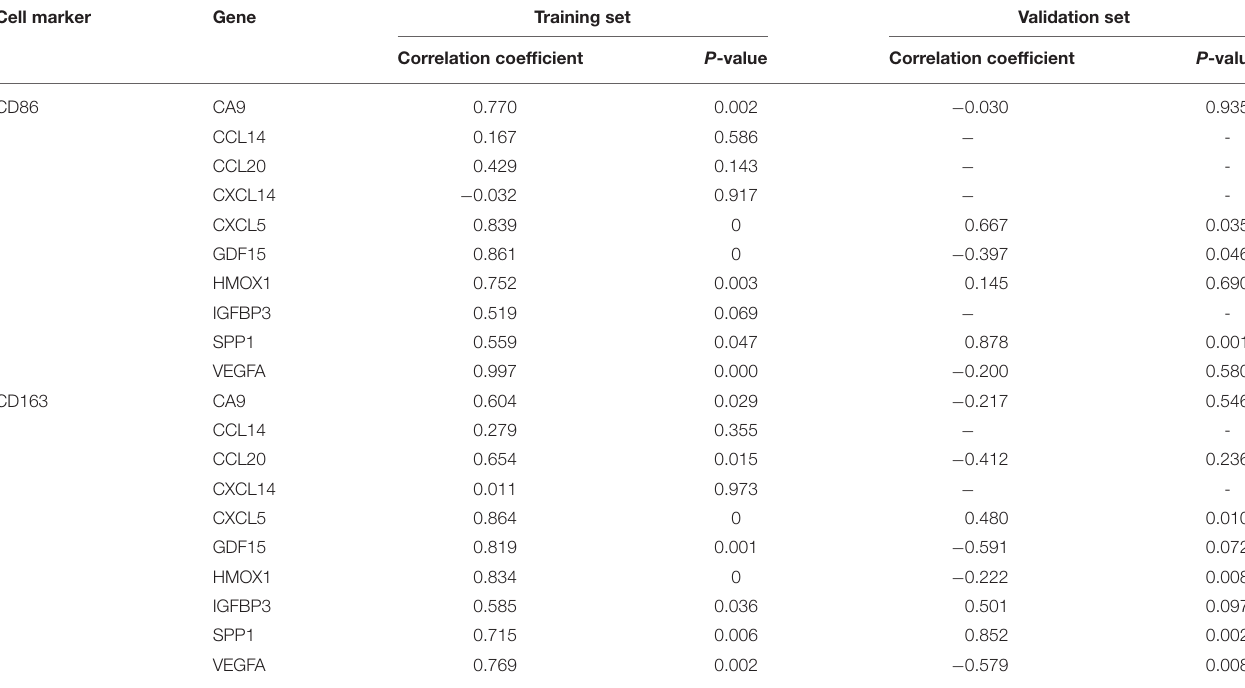
TABLE 3 | Correlation analysis between macrophage M1/M2 and hub genes in the training set and the validation set. Cell